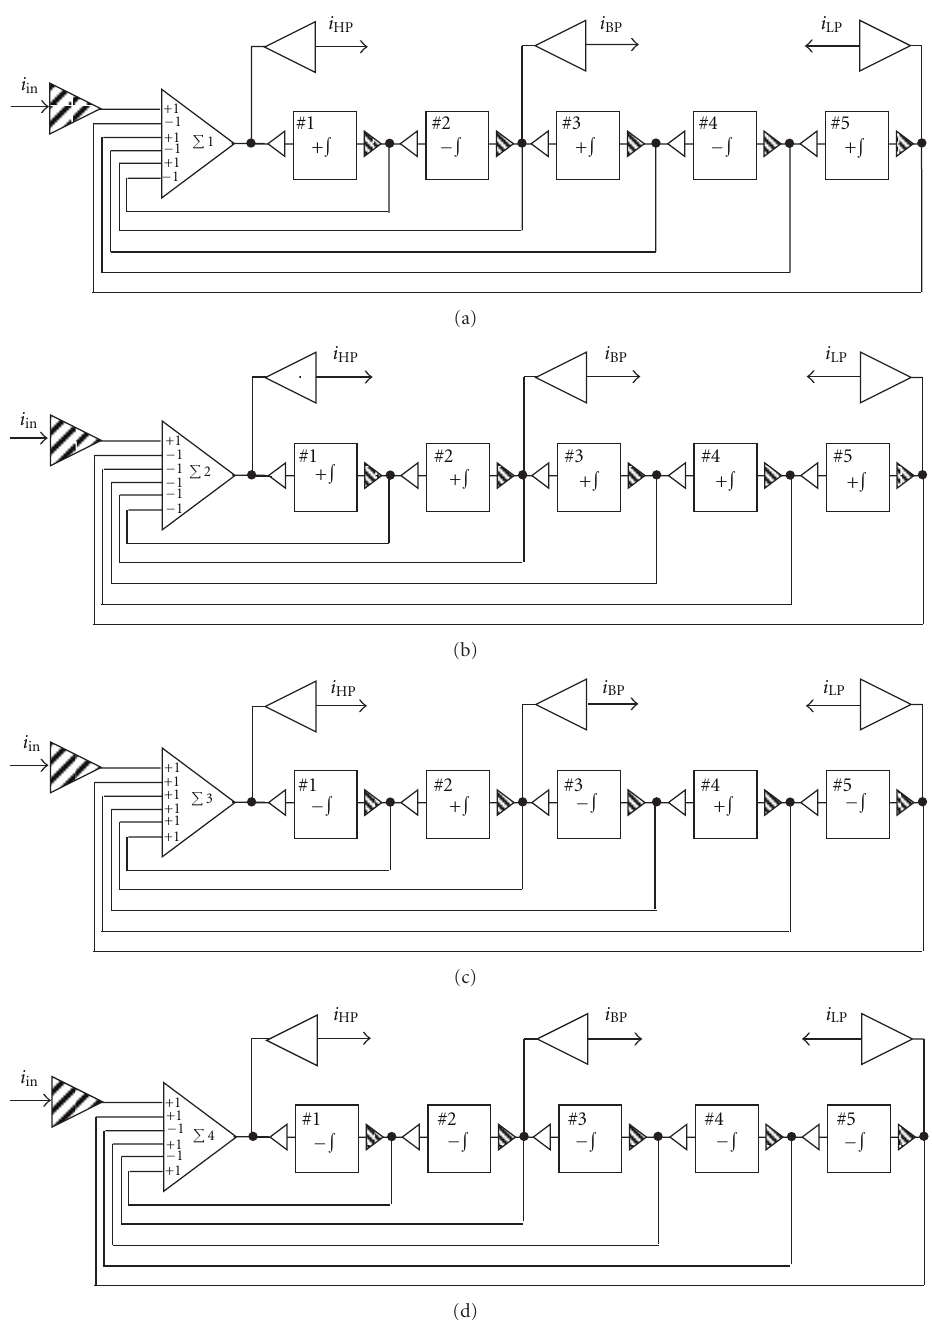
Figure 6: Topologies of the 5th-order generic log-domain MFF of Figure 2. (a) MFF1 (b) MFF2 (c) MFF3 (d) MFF4.